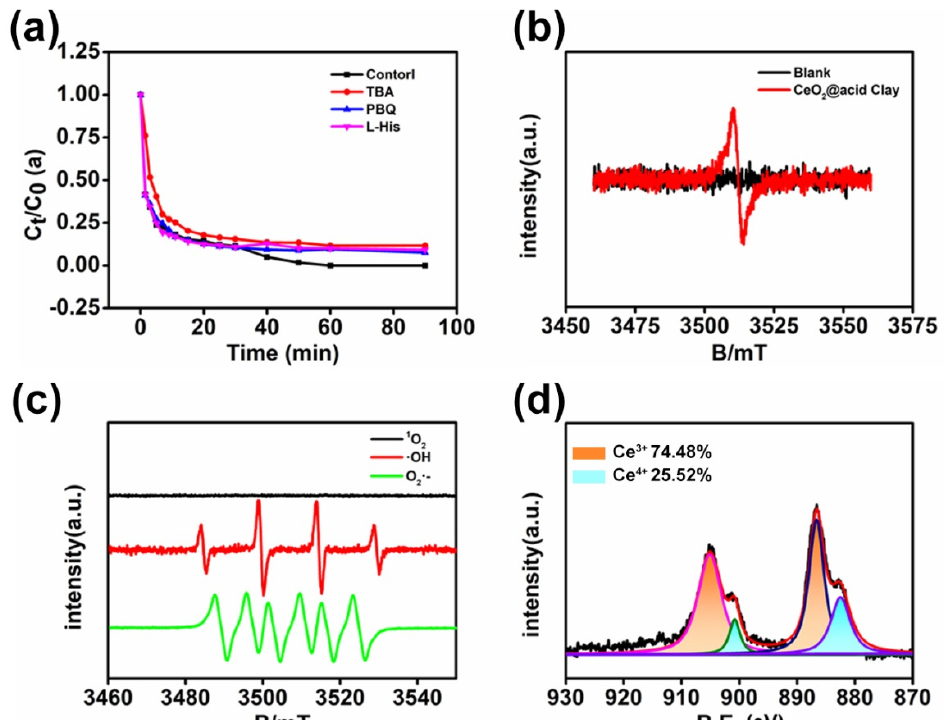
Figure 4. Quenching experiments over CeAY under pH = 1.0 ( a ). EPR spectra ( b ), detection of